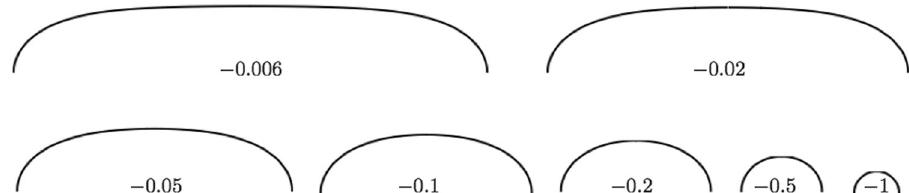
Fig. 3 Pro fi les of sharp-interface GBGs, plotted from eq. (7), with zero dihedral angle. Each steady-state pro fi le is labeled by its η 0 -value. The value η 0 equals the vertical distance between the pro fi le ’ s midpoint and the system ’ s isopotential ζ int = 0. As η 0 → 0, the pro fi le width, or grain boundary separation, diverges, and its midpoint region approaches true fl atness. The limiting periodic GBG con fi guration ( η 0 = 0) formally corresponds to the class of "isolated GBGs'', for which a pro fi le formula consisting of elementary functions was fi rst derived by Bolling and Tiller 29